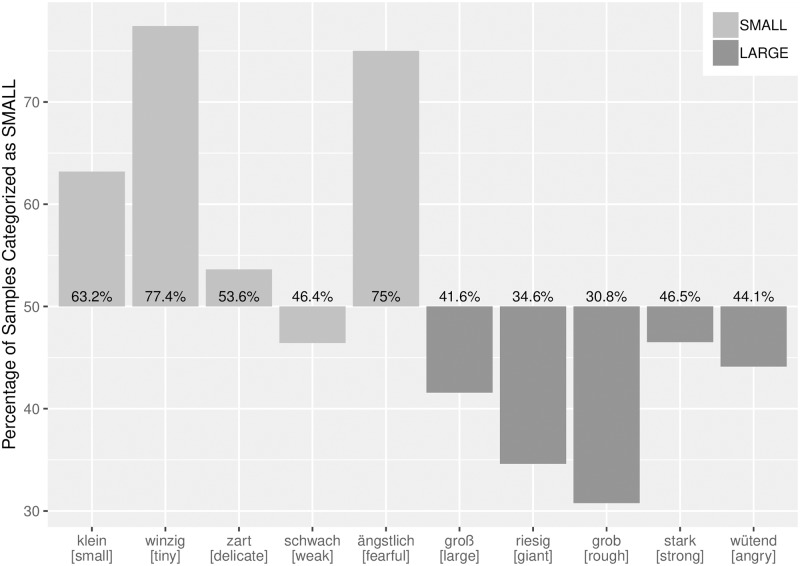
Categorization of target words.Bars represent the percentages for samples that were categorized as SMALL. Orientation of bars indicates the semantic categorization of the target word, with LARGE < 50% and SMALL > 50%.